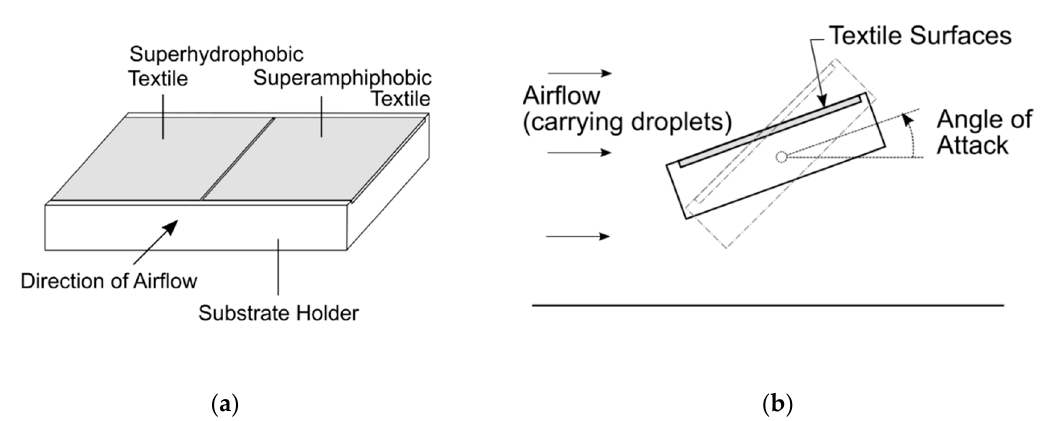
Figure 4. Configuration of fabric mounted to a flat plate sample holder in the icing wind tunnel test section. ( a ) Side-by-side arrangement of fabrics in the flat plate substrate holder; ( b ) Side view of the configuration in the test section showing the direction of airflow, top and bottom test section walls, and the two tested angles of the sample holder.